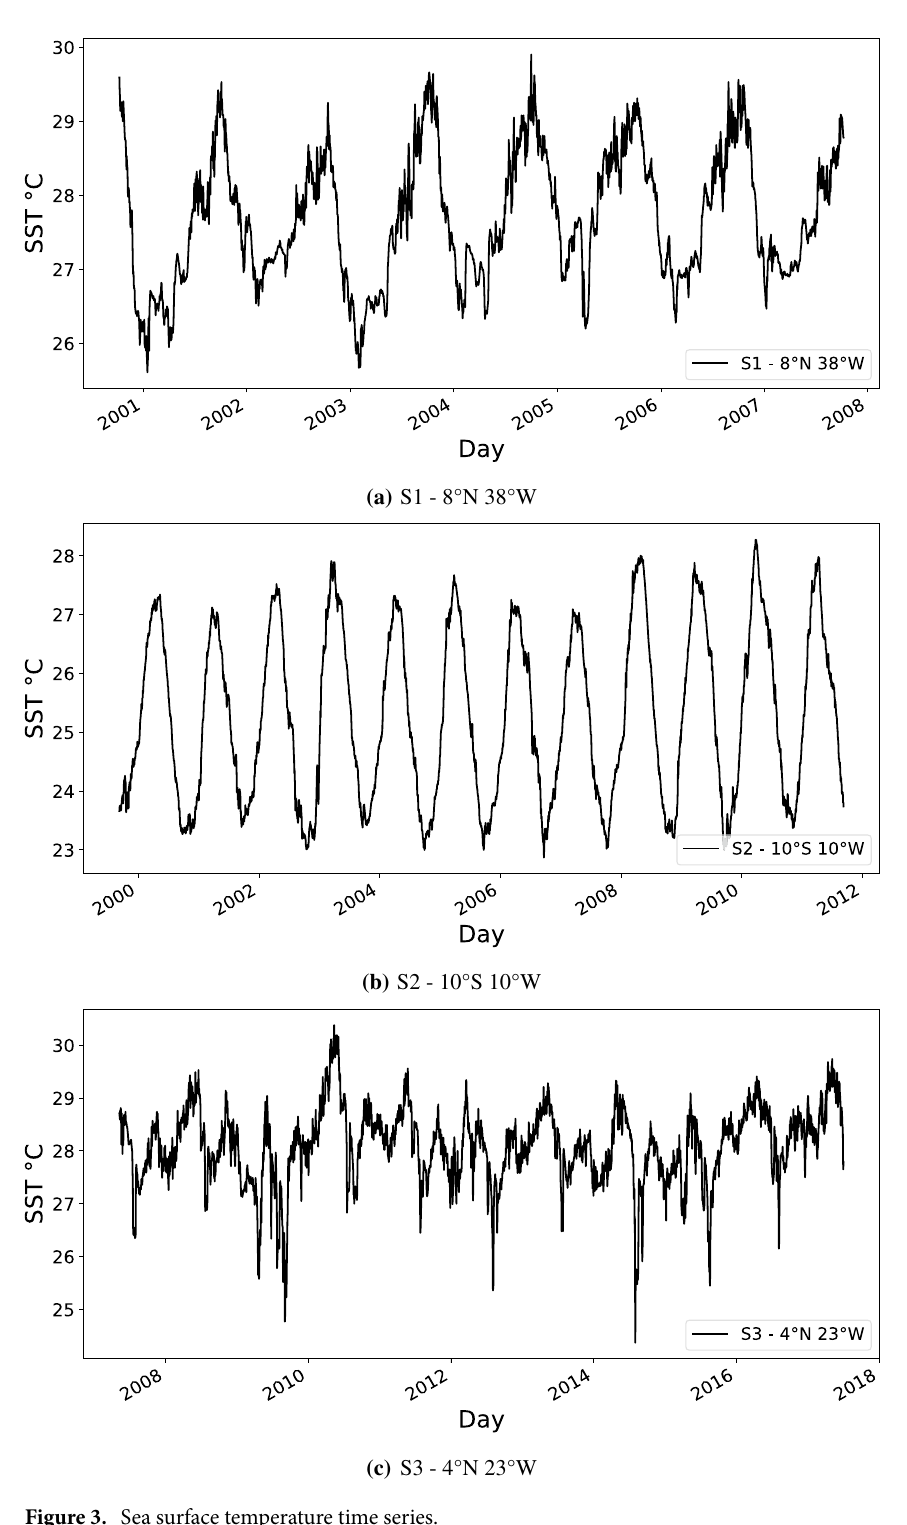
Figure 3. Sea surface temperature time